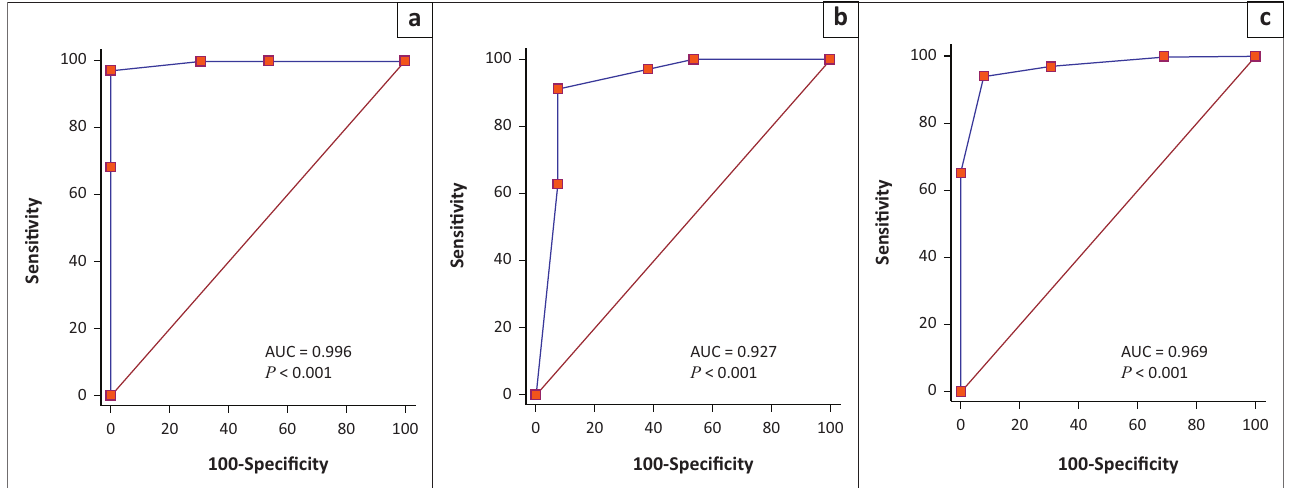
FIGURE 1: The receiver operating characteristic curve (ROC) for each reader for differentiating benign from malignant liver lesions. (a) R1; (b) R2; (c)